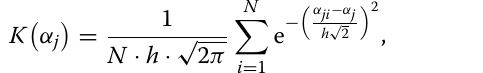
tional file 1: Table S1, we have listed all the observatories (IAGA code) used for the IGRF parent